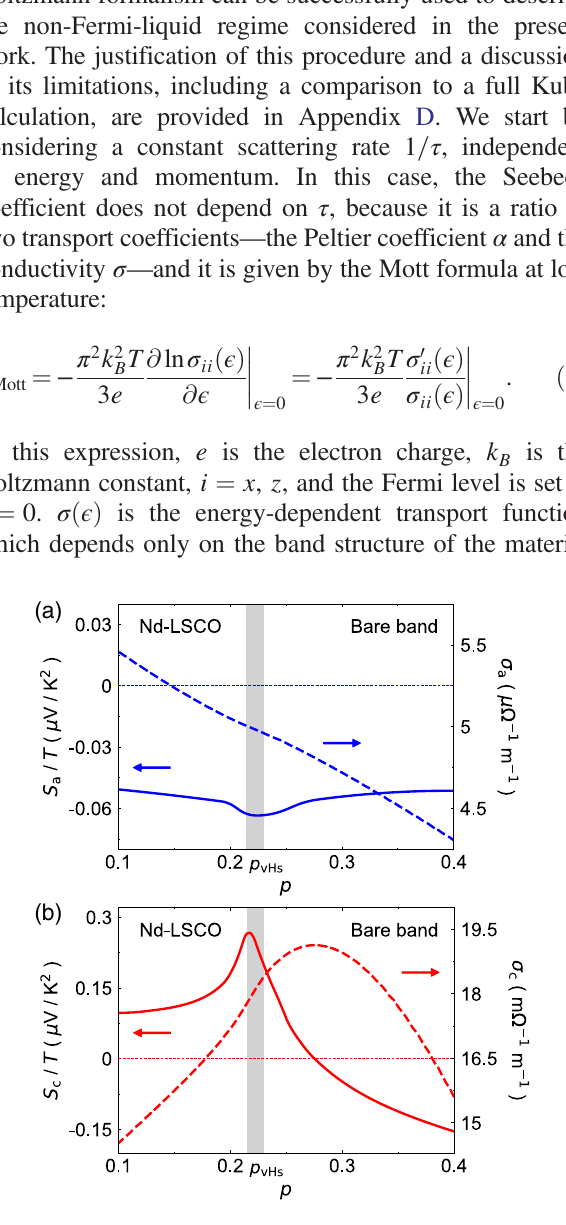
FIG. 7. Calculations of the Seebeck coefficient ( S=T , full line, left axis) and conductivity ( σ , dashed line, right axis) as a function of the doping from the bare band dispersion of Nd-LSCO, as measured by ARPES [15,27], with an energy-independent scattering rate 1 = τ . (a) In-plane coefficients at T ¼ 6 K; (b) out-of-plane coefficients at T ¼ 6 K. We can see from the figures that the sign of S=T is set by the slope of the conductivity σ as a function of the doping. This reflects the Mott formula in Eq. (2). The minimum in S a =T and maximum in S c =T coincide approximately with the van Hove point ( p , gray band) where vHs the Fermi surface goes from holelike (below p ) to electronlike vHs (above p vHs